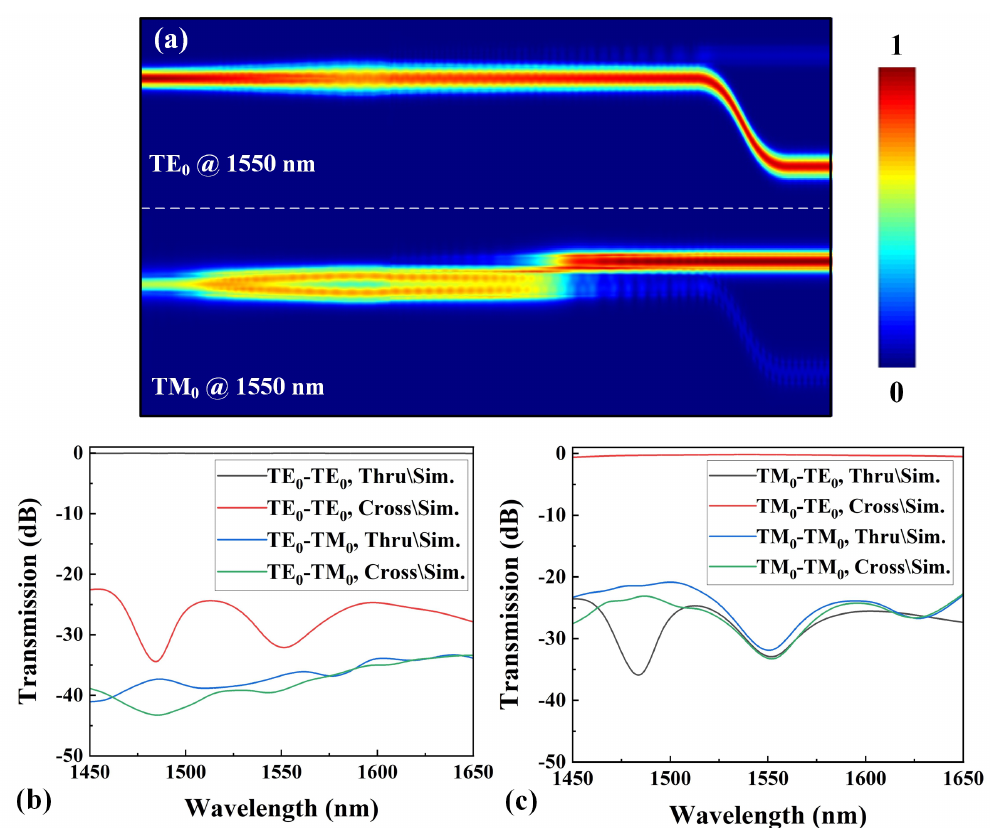
Figure 3. ( a ) Simulated optical power distribution along the designed PSR in case of TE 0 or TM 0 injection. Transmission spectrum for ( b ) TE 0 injection and ( c ) TM 0